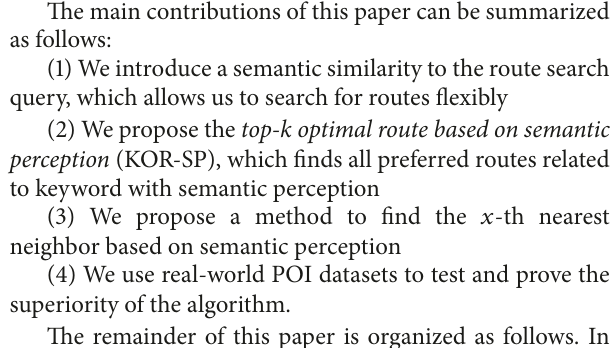
Figure 1: An example of keyword